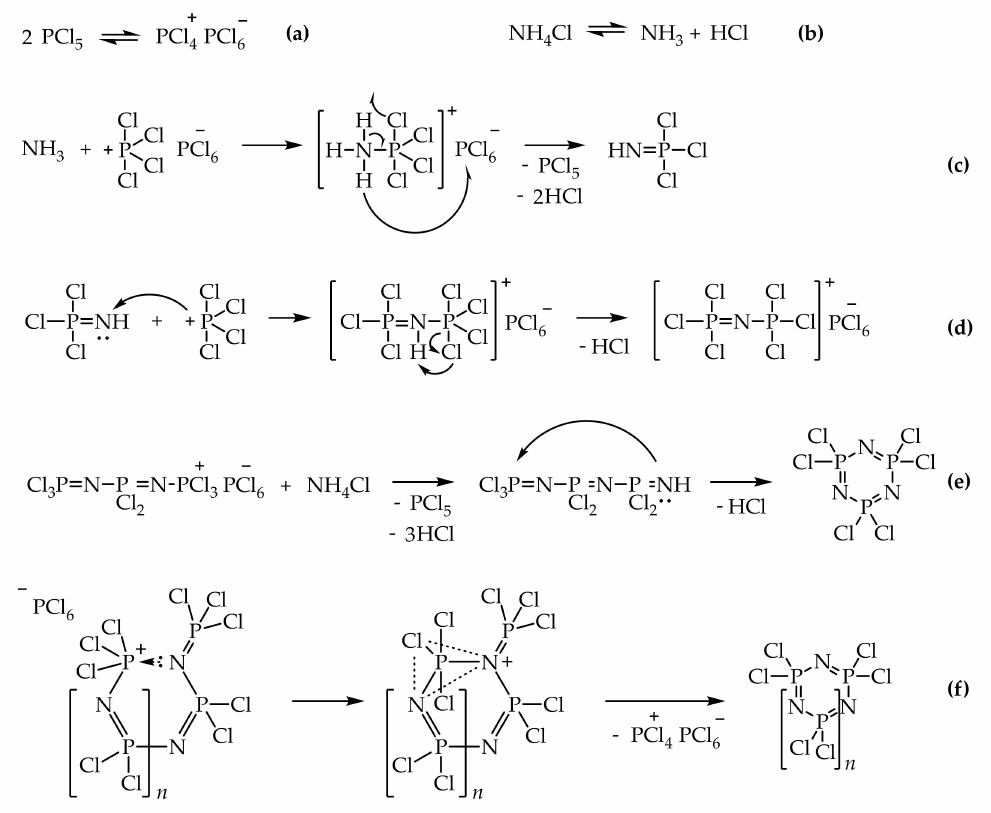
Figure 2. The mechanism of the formation of cyclic chlorophosphazenes proposed by Becke-Goehring et al. [36] ( a – e ), and alternative cyclization mechanism proposed by Emsley et al. ( f ) [37].